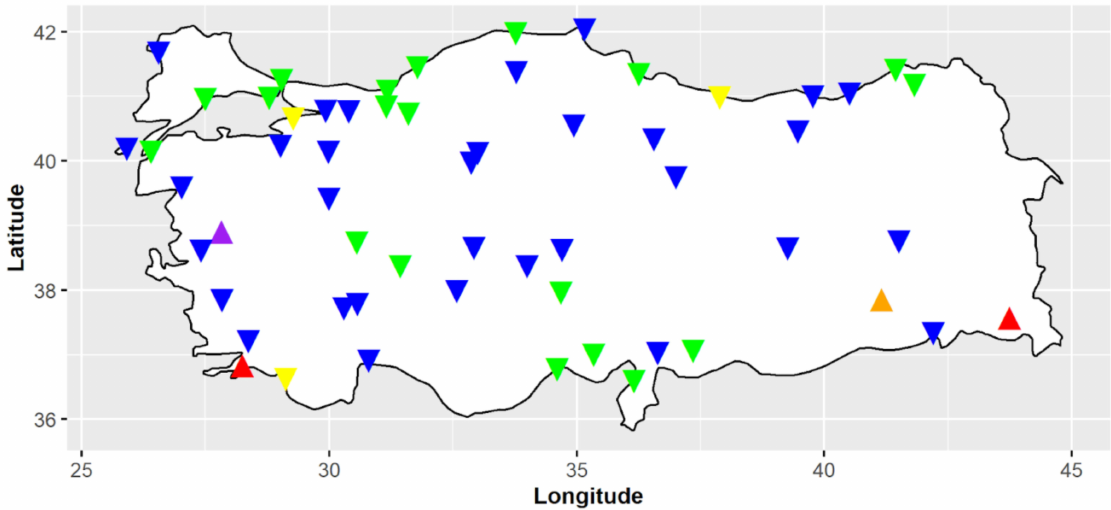
Figure 8. Mann-Kendall trend results of TCI values for summer (See Figure 6 for